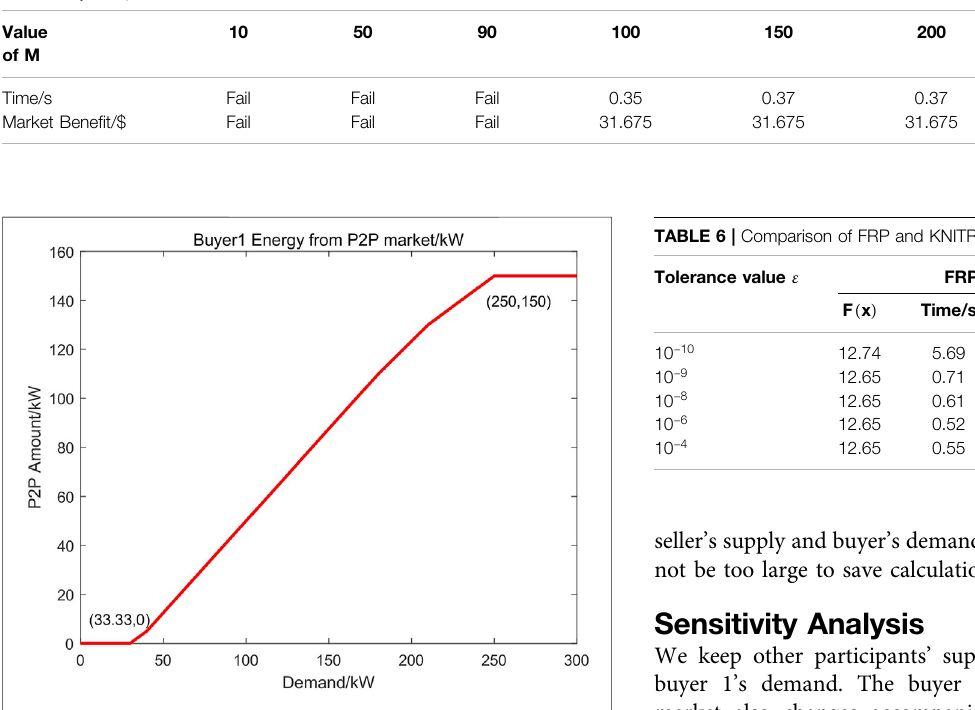
FIGURE 8 | Buyer 1 ’ s energy from the P2P market.